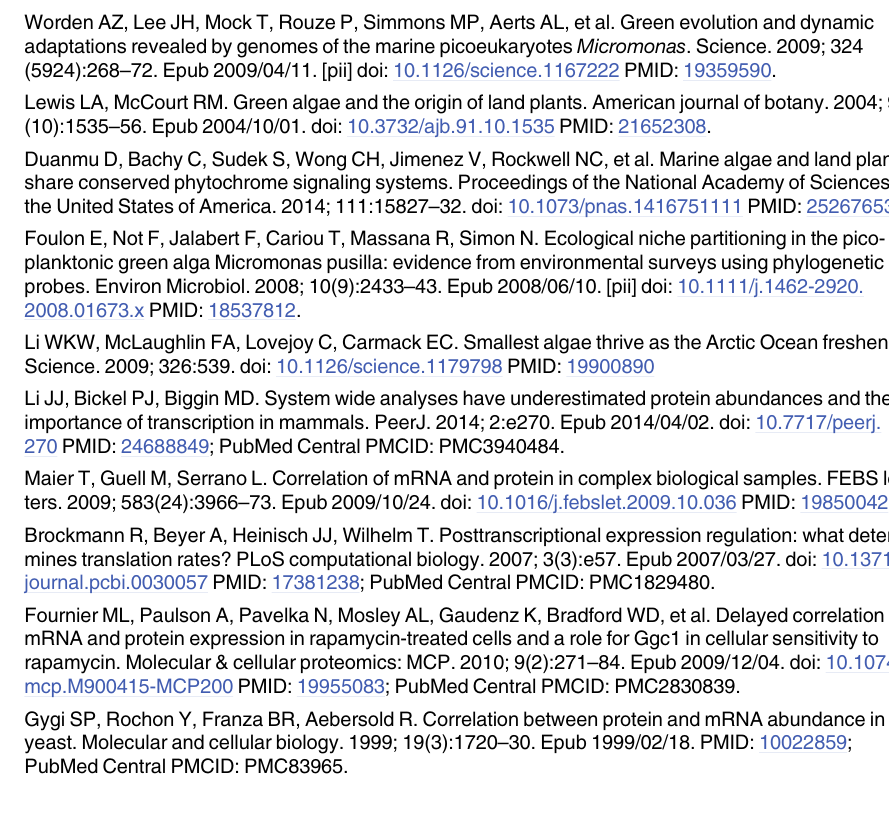
S1 Table. Progressive differential protein expression. This table contains a detailed list of dif- ferentially expressed genes, as determined by a progressive scan where protein expression from one time point was compared with data from the subsequent time point just prior to it, e.g. T2 compared with T3. In the case of T4, this was compared with the data from T1. S2 Table. Oxygenic Photosynthesis clusters. This table contains information regarding the clusters that were either enriched or contained genes from the Oxygenic Photosynthesis (OP) pathway, including gene name, as well as GO term and EC number annotations. Note, EC numbers were annotated using Pathway Tools, as described in the Materials and Methods sec-